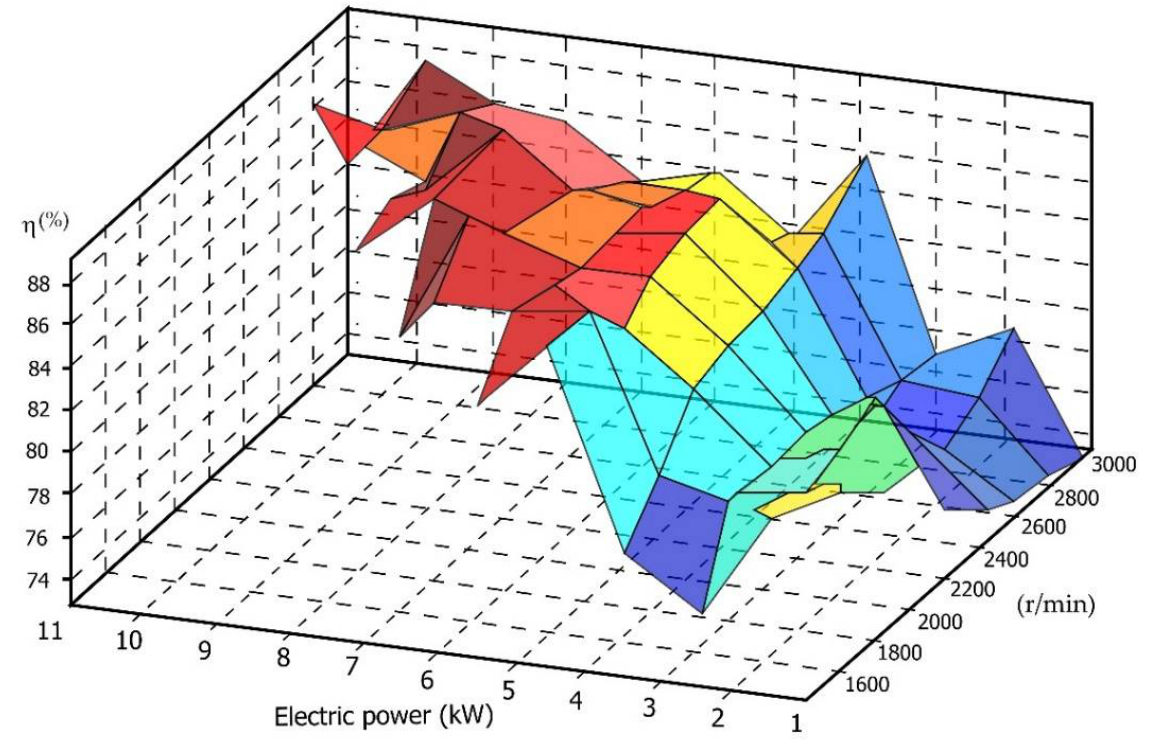
Figure 5. Efficiency η for a cogenerator system [22].